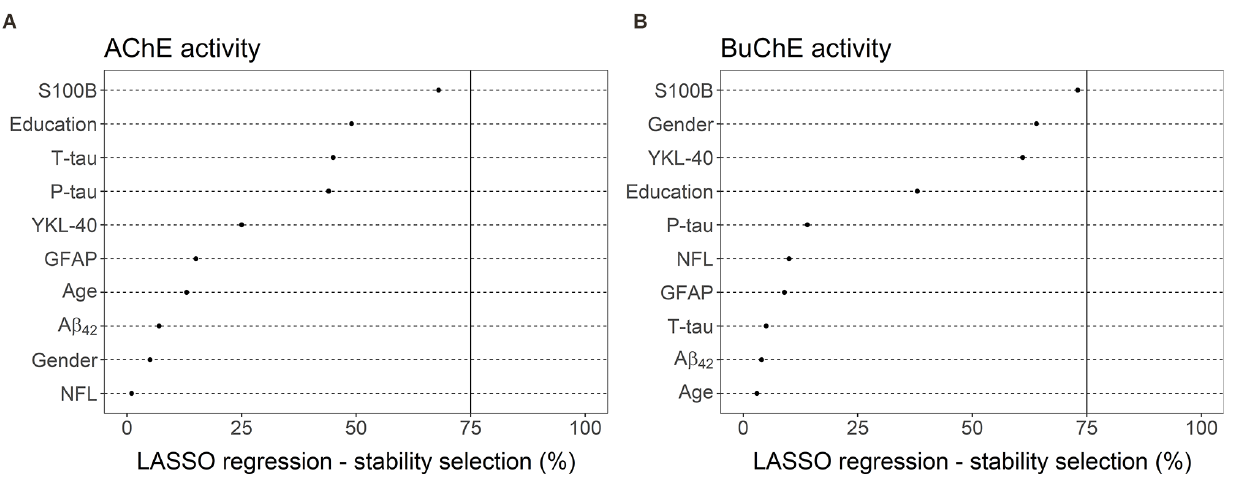
FIGURE 5 | LASSO linear regression—stability selection analyses for the identification of a set of variables predicting CSF enzyme activities of (A) AChE and (B) BuChE with the highest consistency. The cut-off selection value was set at 75% and the per-family error rate (PFER) at 1. Variables selected into the model at least